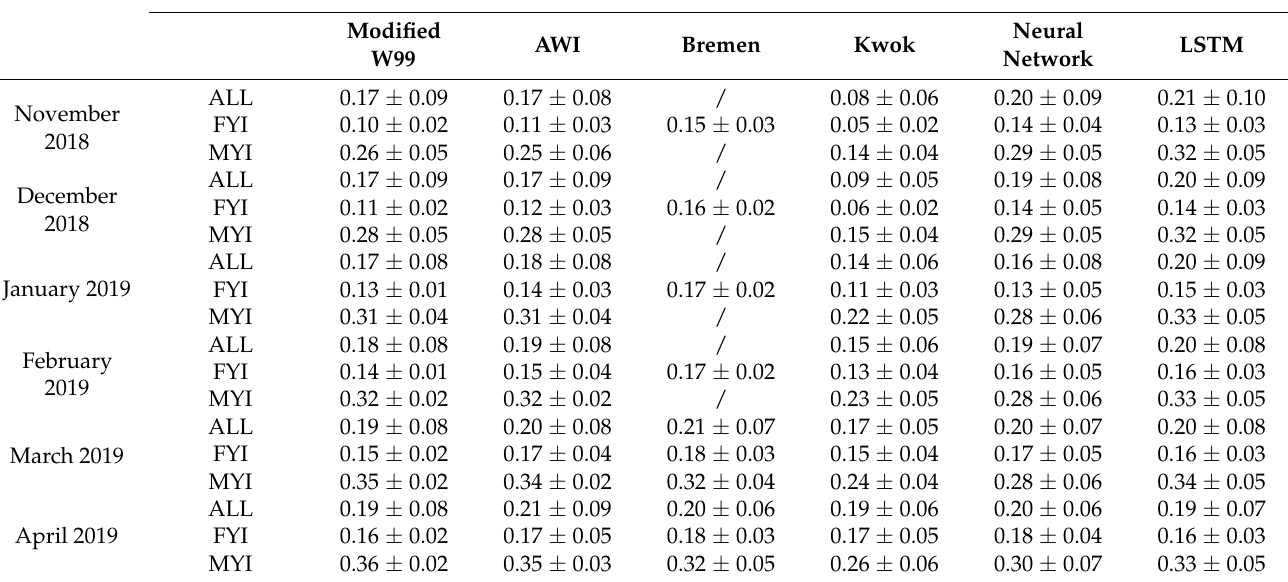
Table 2. Statistical table of the seasonal variations in the different snow depth products over the common area of all data